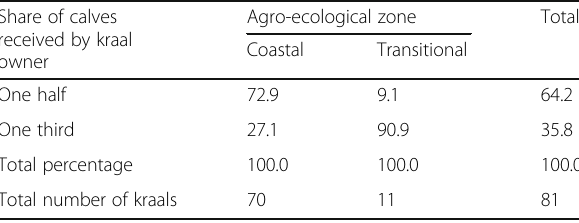
Table 3 Distribution (percentage) of kraal owner ’ s share of calves by agro-ecological zone Share of calves received by kraal